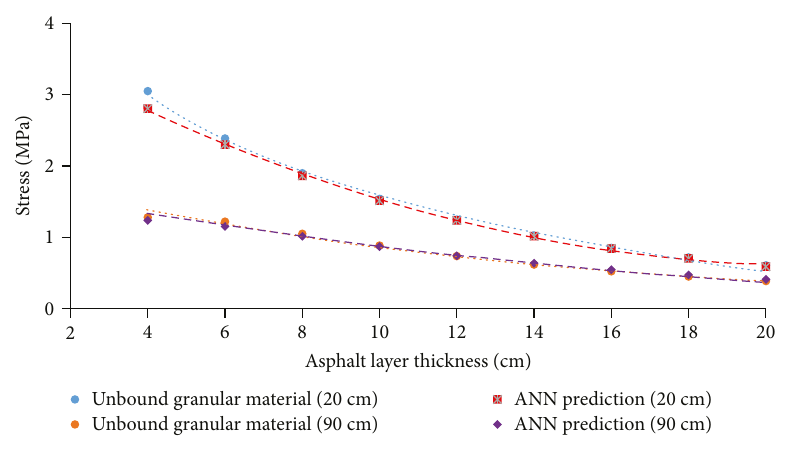
Figure 9: Results — case